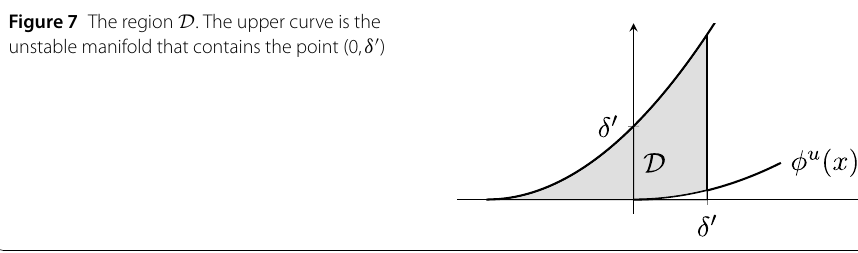
Figure 7 The region D . The upper curve is the unstable manifold that contains the point (0, δ (cid:10) )